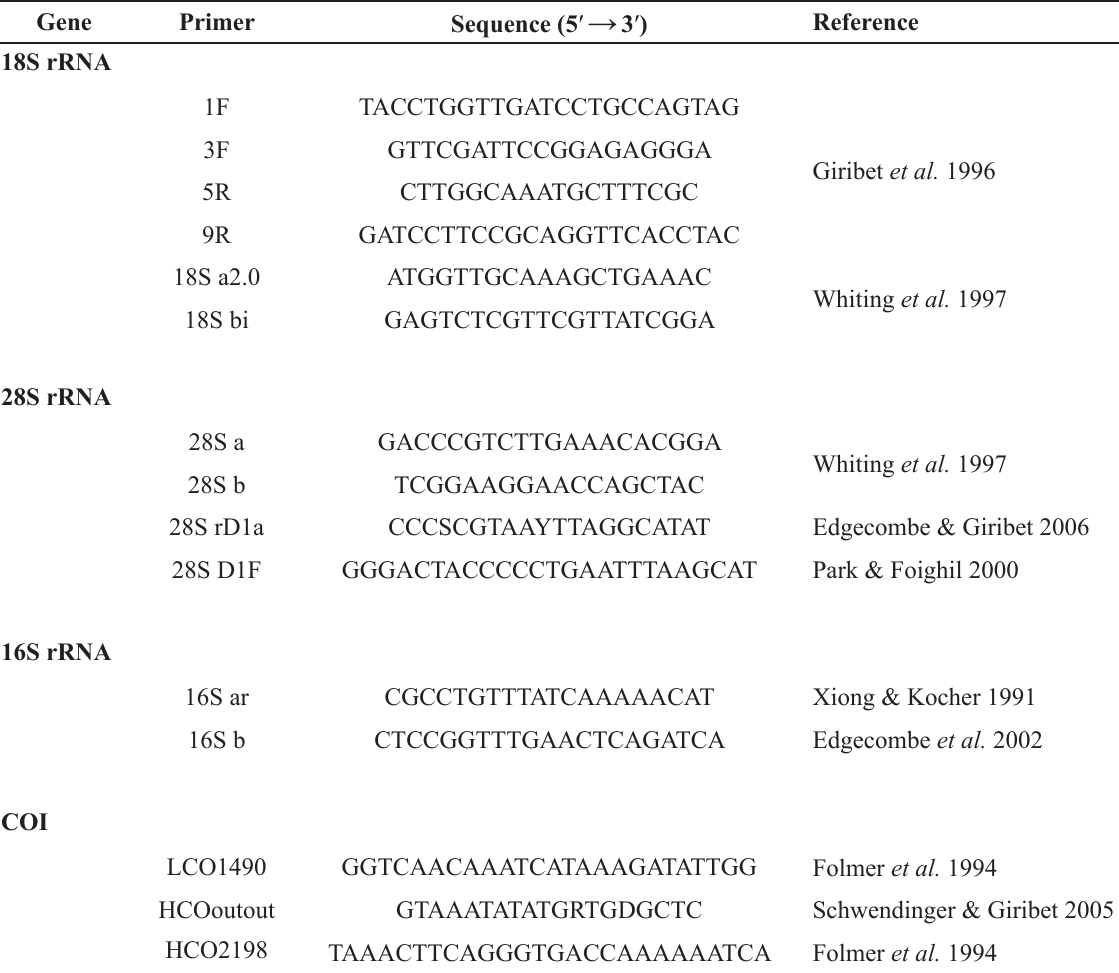
Table 1. Primer sequences for four gene fragments and corresponding